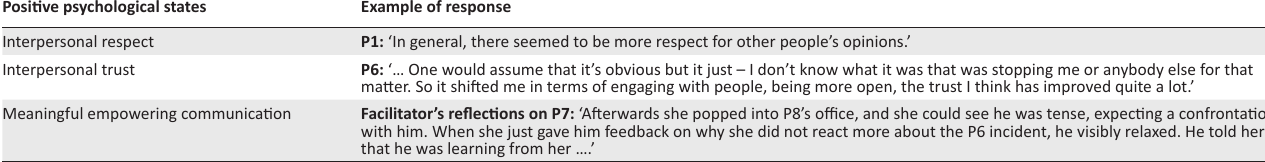
TABLE 4: Examples of positive psychological states. Positive psychological states Example of response Interpersonal respect Interpersonal